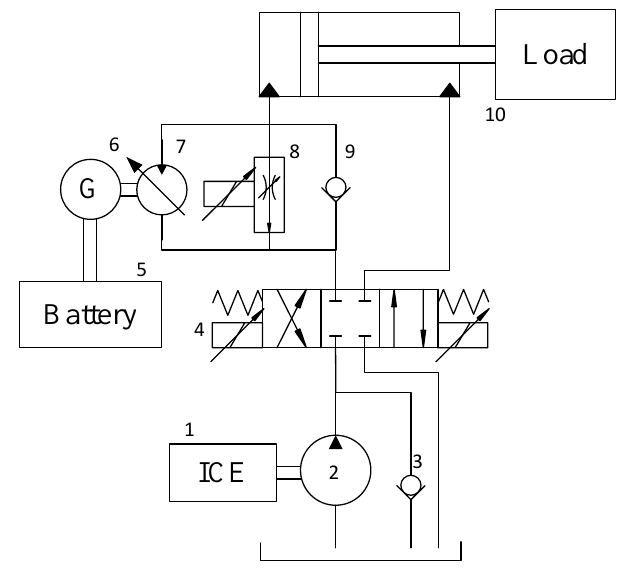
Figure 1. Hydraulic circuit of the previous research.